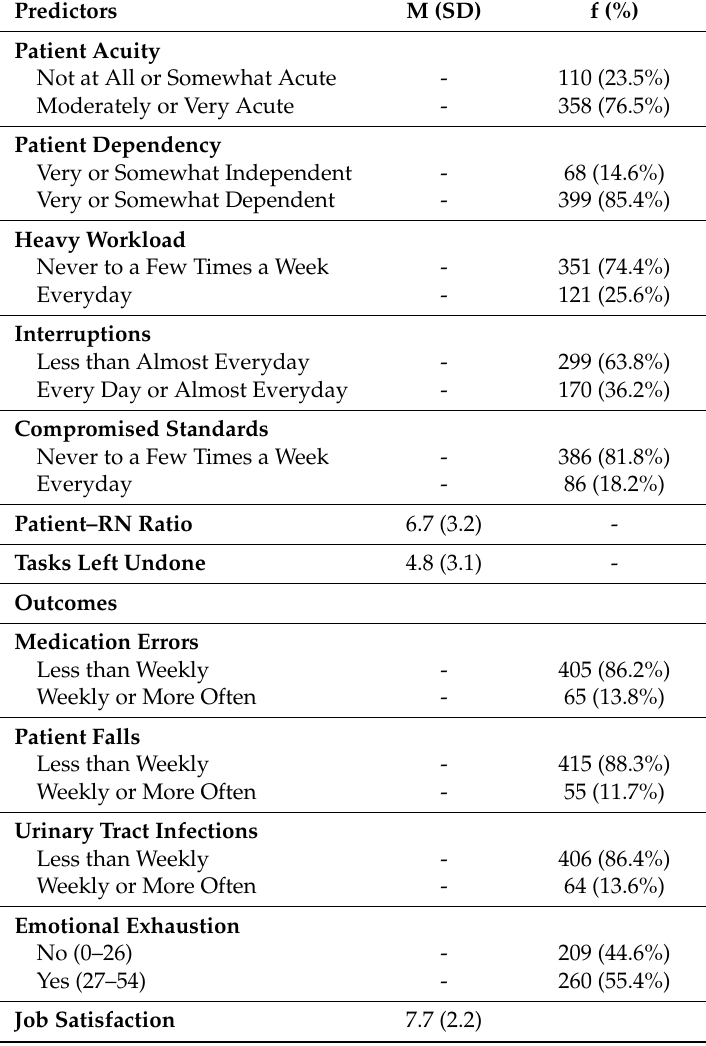
Table 2. Descriptive statistics for key predictors and outcome variables ( N =